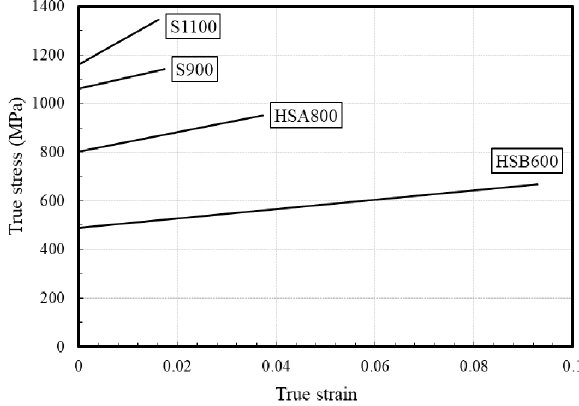
Figure 6. True stress–strain curves for parametric analysis.